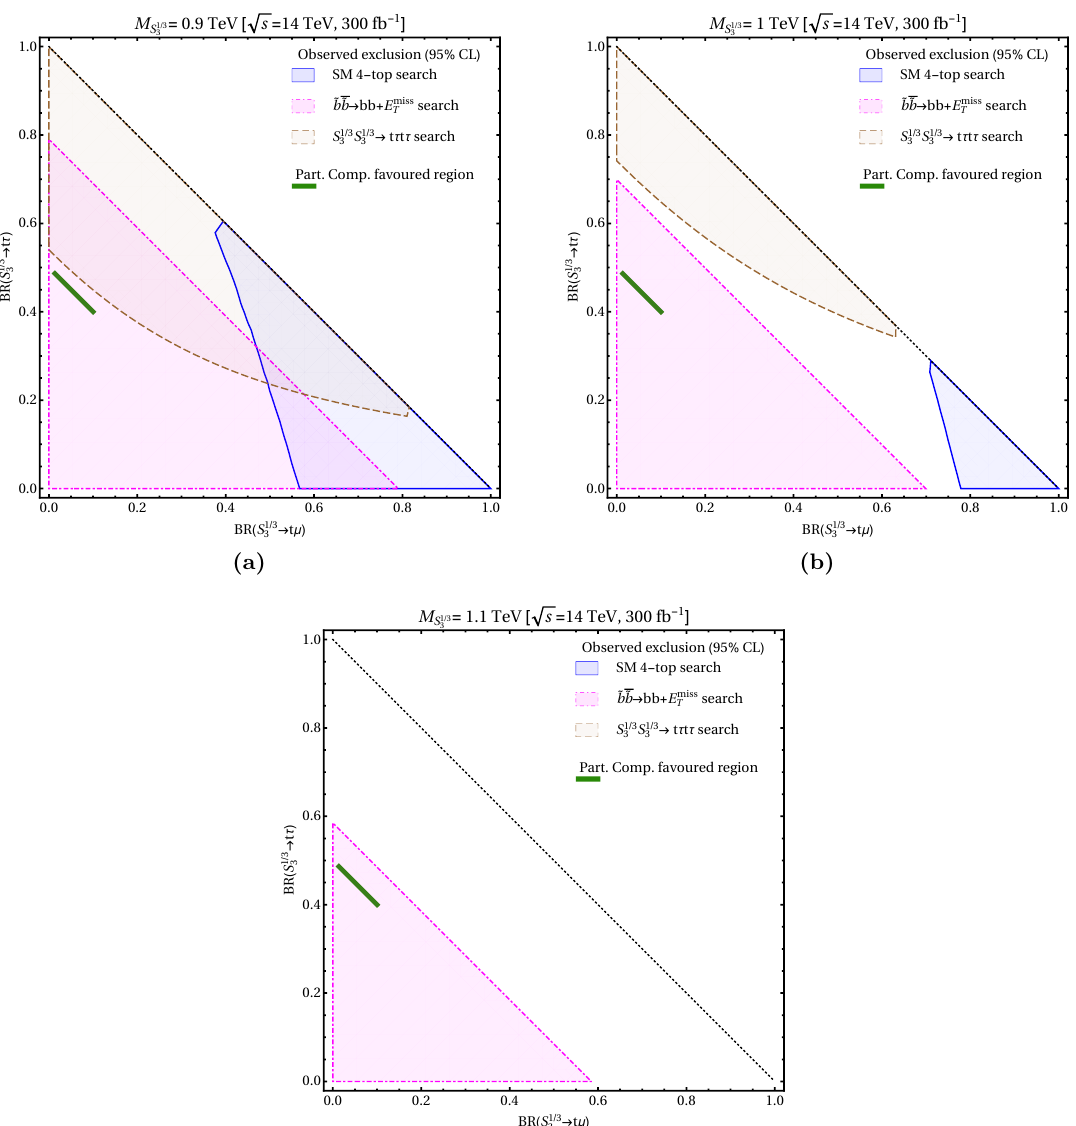
Figure 2. Projected bounds on the S 1 = 3 leptoquark branching ratios into t(cid:28) , t(cid:22) , and b(cid:23) based on 3 p recent LHC searches extrapolated to 300 fb (cid:0) 1 of pp collisions at s = 14 TeV, for di(cid:11)erent values of the leptoquark mass M : (a) 0.9 TeV, (b) 1 TeV, and (c) 1.1 TeV. Also shown is the region S 1 = 3 3 preferred by our partial compositeness model. The area above the diagonal line corresponds to the unphysical region where the sum of branching ratios exceeds unity, or is smaller than zero.